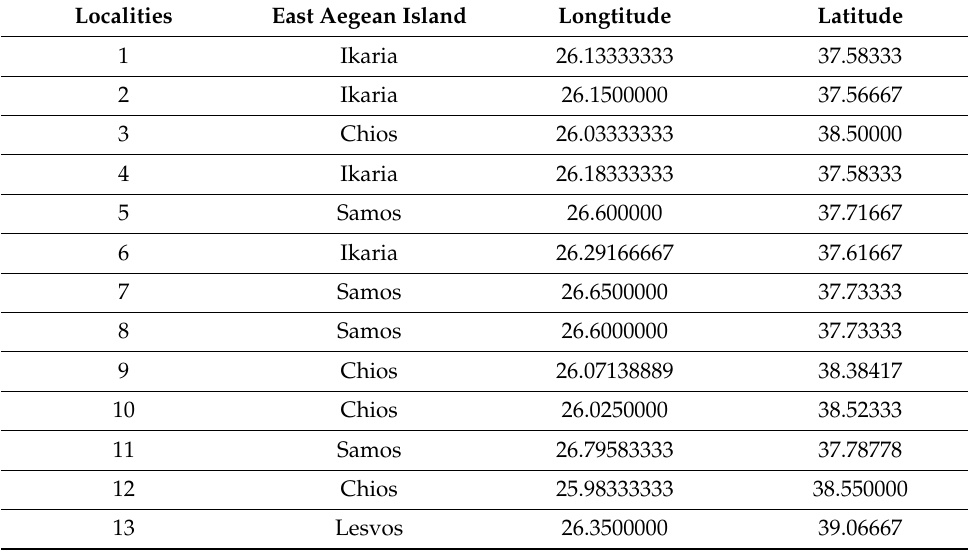
Table 6. Compilation of all known Sideritis sipylea localities in Greece representing its natural distribution in four islands of the Eastern Aegean Archipelago in WGS84 coordinate